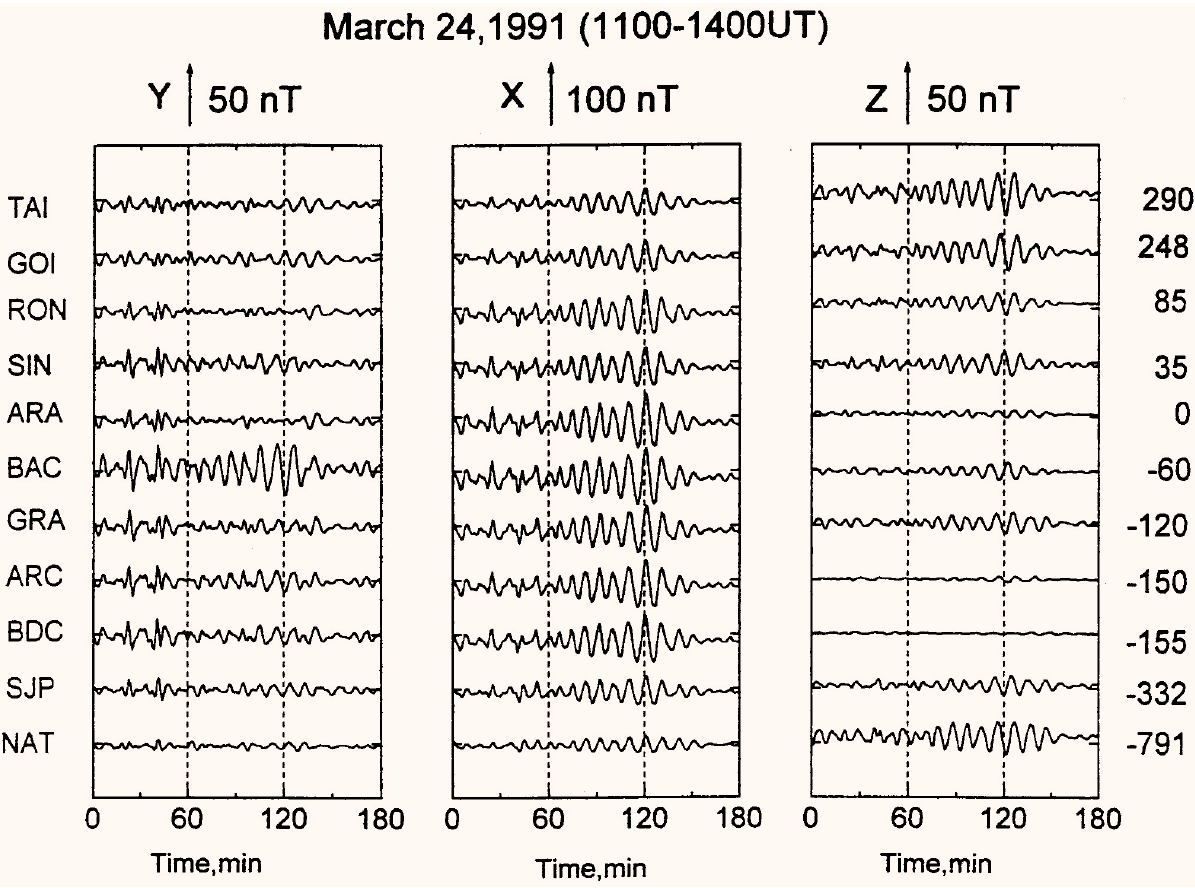
Fig. 3. Filtered geomagnetic field variation in Y , X , Z in association with the Pc5 pulsations during 1100–1400 UT, 24 March 1991. Plots are stacked according to the distance of stations with respect to the dip equator. Table 1. Polarization parameters for the Pc5 event of 24 March 1991 (1100–1400UT)